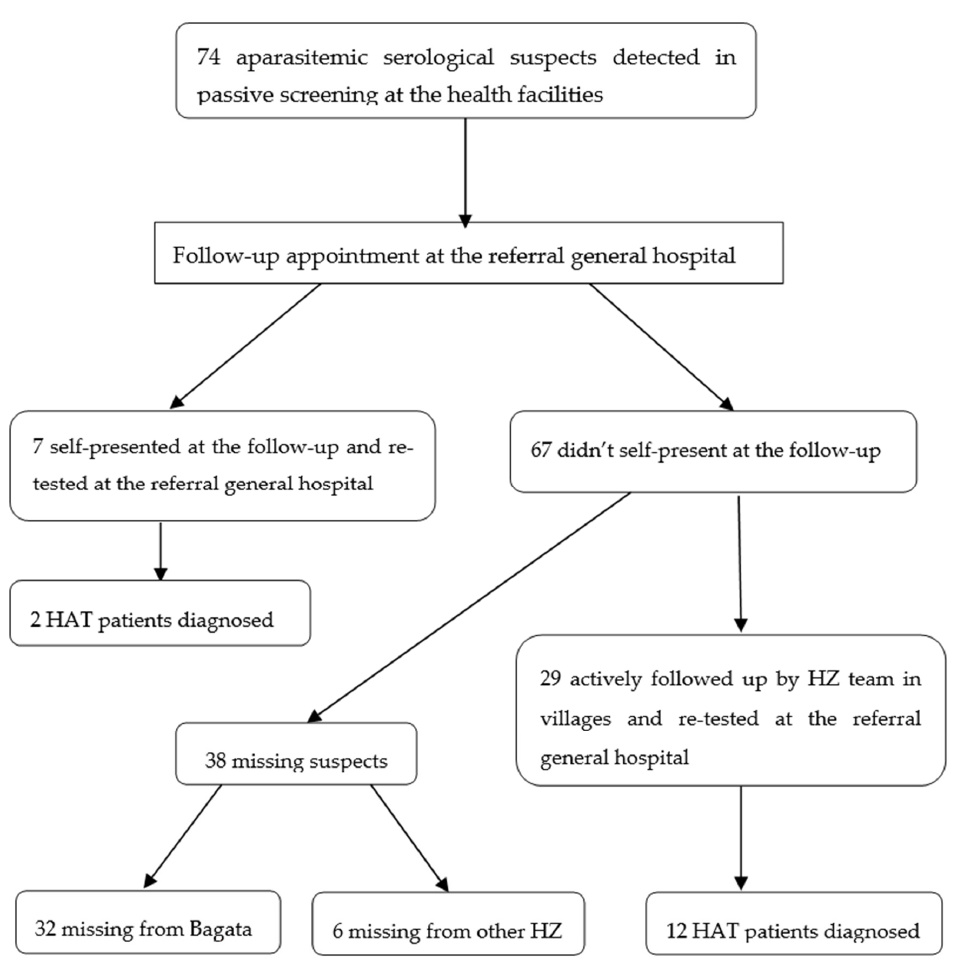
Figure 1. Flow diagram including passive approach (spontaneous visits after sensitization) and active follow-up strategy.